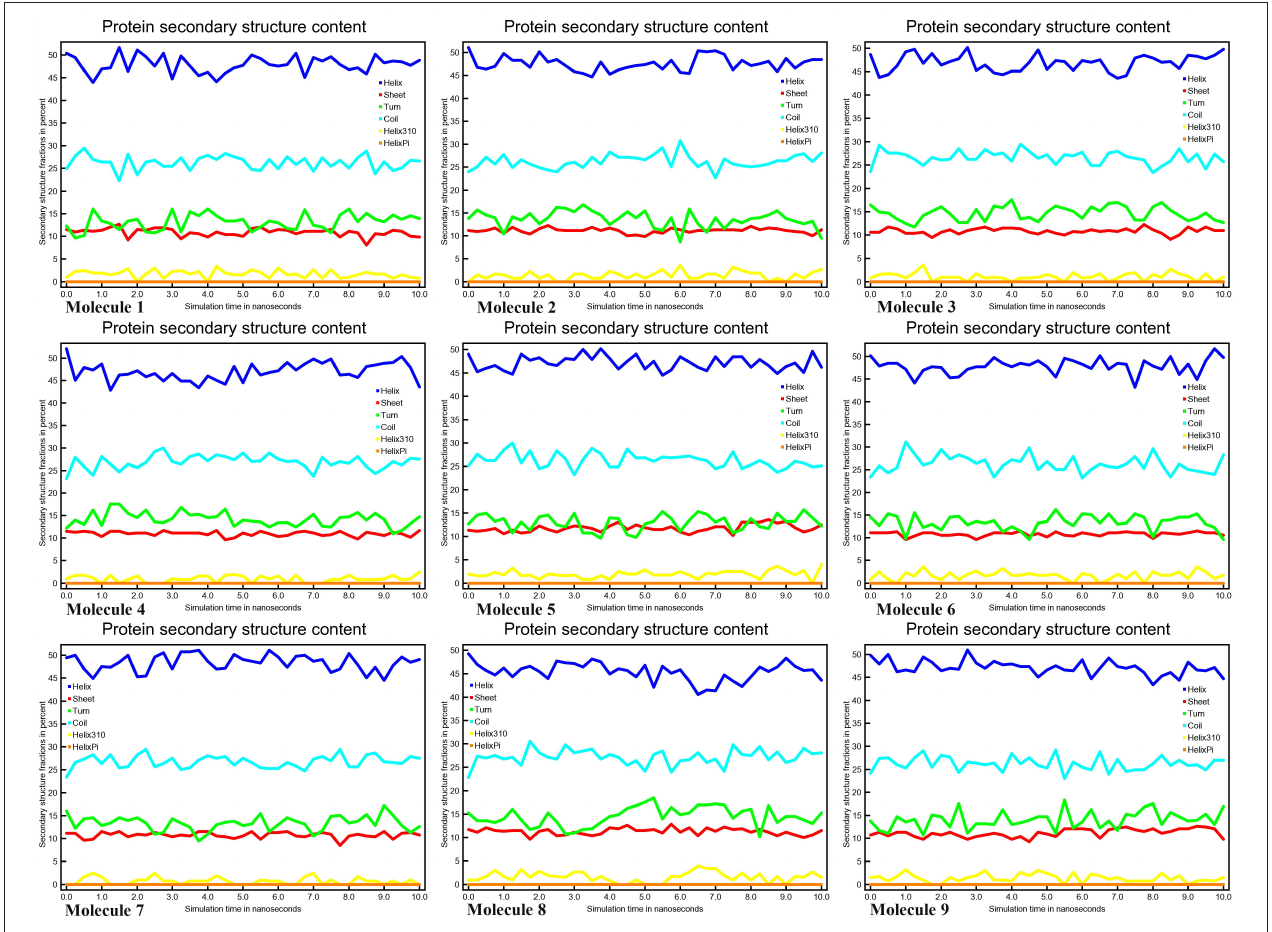
FIGURE 9 | Protein secondary structure content calculations of CYP51 and nine molecules as a function of 10 ns simulation time.